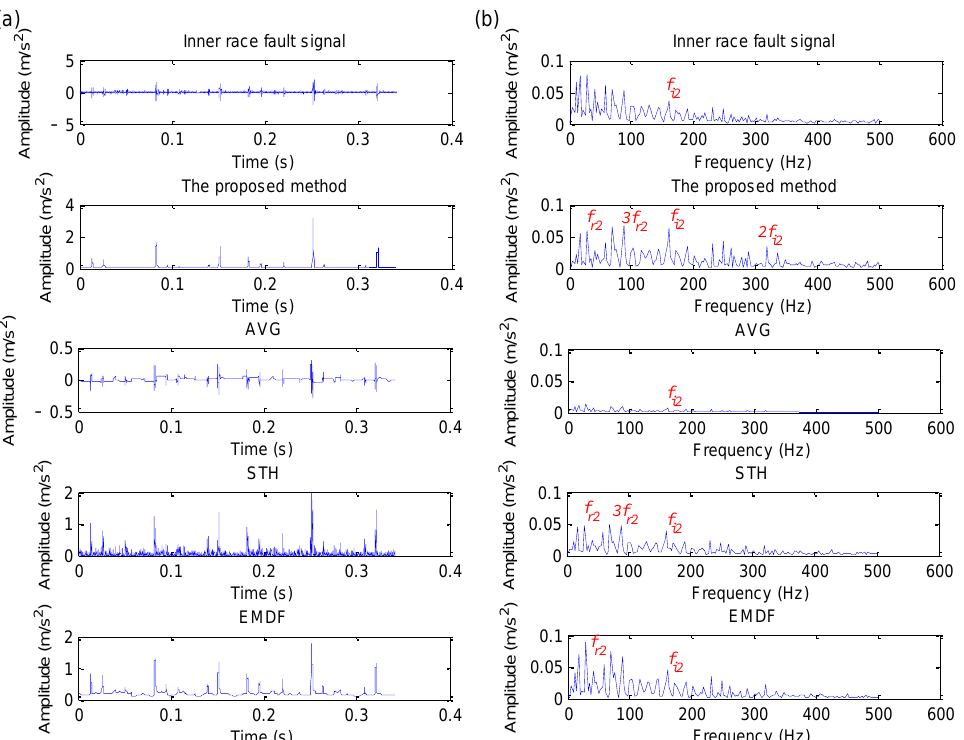
Figure 18. Analysis results obtained by different methods for dataset 130 in case 2: ( a ) Time domain waveform; ( b ) its corresponding envelope spectrum.